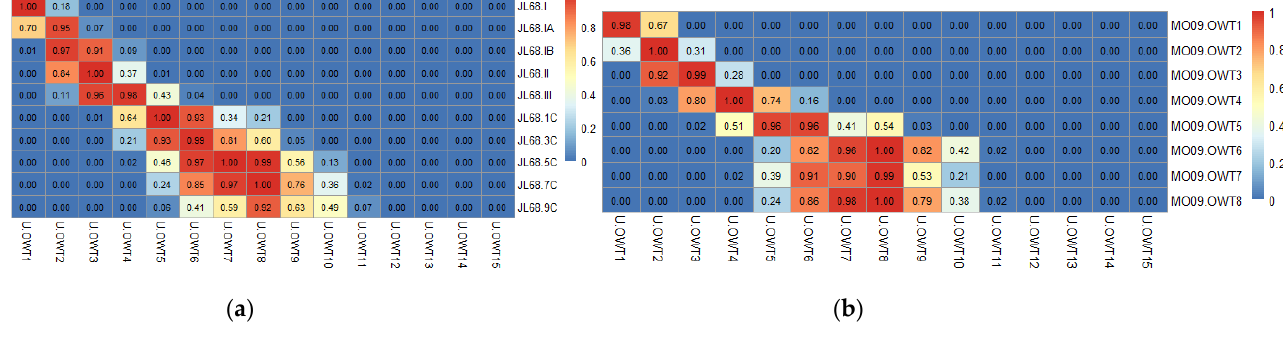
Figure 3. Mean n R rs ( λ ) spectra of U-OWT classes 1–15 corresponding to the hyperspectral (PACE) and different multispectral (SeaWiFS, MERIS, MODIS-A, OLI, VIIRS-N, MSI-S2A, and OLCI-S3A) satellite sensors.